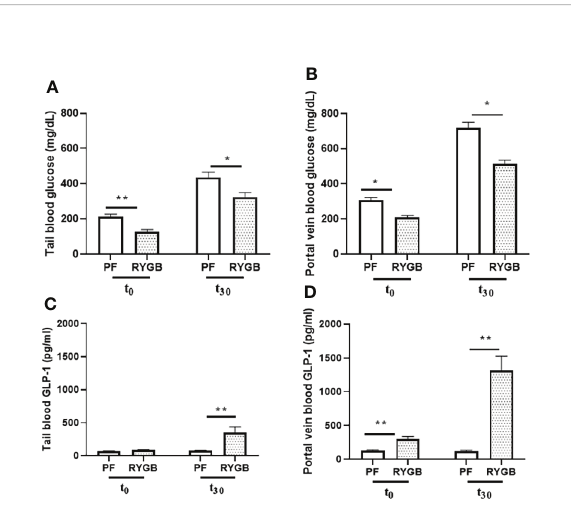
FIGURE 2 Effect of RYGB on peripheral and portal venous glucose and GLP-1 levels. On POD 21, tail and portal vein blood were collected after fasting (T 0 ) and at 30 minutes (T 30 ) after rats underwent gavage with 1.25g/kg 25% dextrose. Glucose levels (A, B) were measured by glucometer. And GLP-1 levels (C, D) were assayed by ELISA. Data are mean ± SE, n=9-13 per group, *p<0.05, **P<0.01.